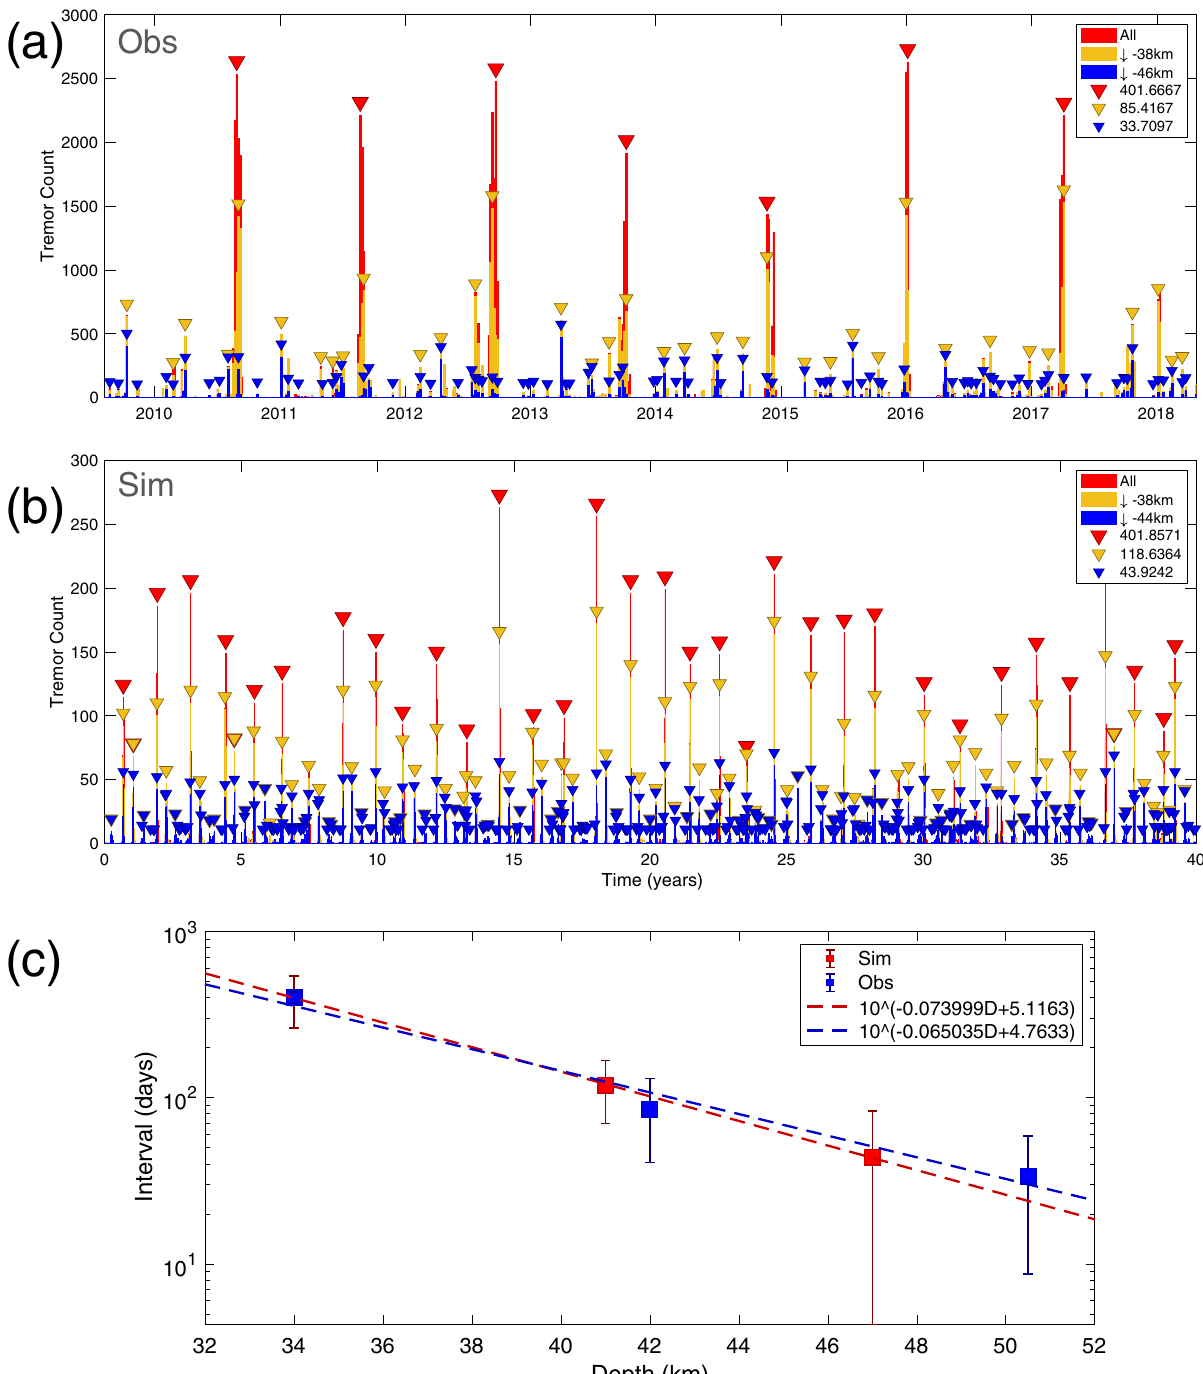
Fig. 8 Comparison of the spatiotemporal distribution of episodic tremor and slow-slip (ETS) between observation and rate-and-state model. a Observations over the period of August 2009 – April 2018. Similar to Fig. 1b, red, yellow, and blue triangles indicate automatically picked ETS events at shallow (<38 km), mid (38 – 46 km), and deep (>46 km) depth. The average event intervals are approximately 401.7, 85.4, and 33.7 days, respectively. b Results from the linear rate-and-state model in 40-year simulation. ETS events at shallow (<38 km), mid (38 – 44 km), and deep (>44 km) depth have average intervals of 401.9, 118.6, and 43.9 days, respectively. c The ETS interval-depth (center depth of each ETS bin) relations from observations (blue) and model (red) follow a strikingly similar exponential distribution (error bar = 1 standard deviation, dash-lines: linear